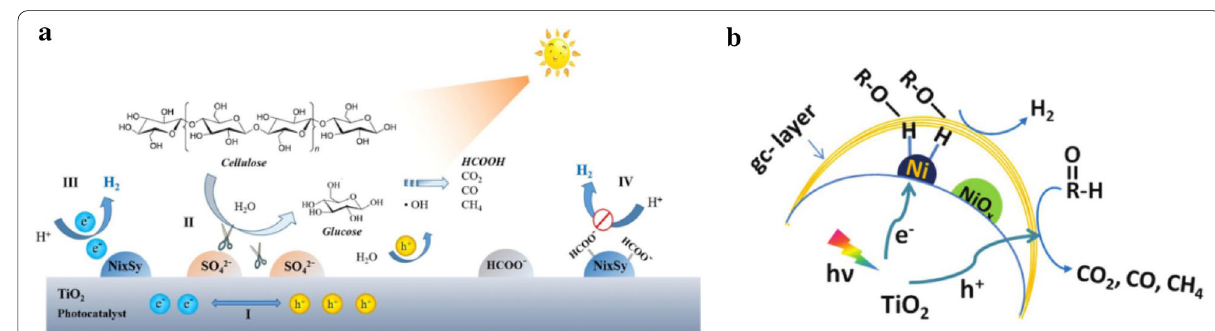
Fig. 5 Proposed mechanism of cellulose photoreformation into H 2 over a NiS/TiO 2 and b NiOx/TiO 2 . Reprinted with permission from Hao et al. [41] and Zhang et al. [42] (Copyright 2018 ChemPubSoc Europe and Royal Society